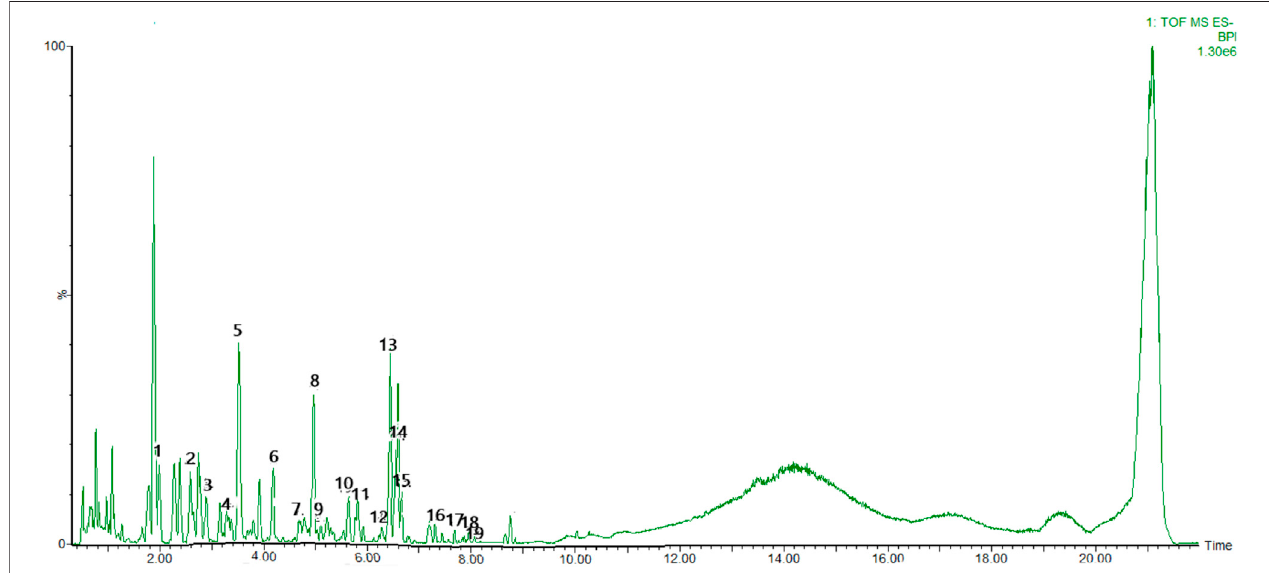
FIGURE 2 | Base peak chromatogram with negative mode of the aqueous extract of